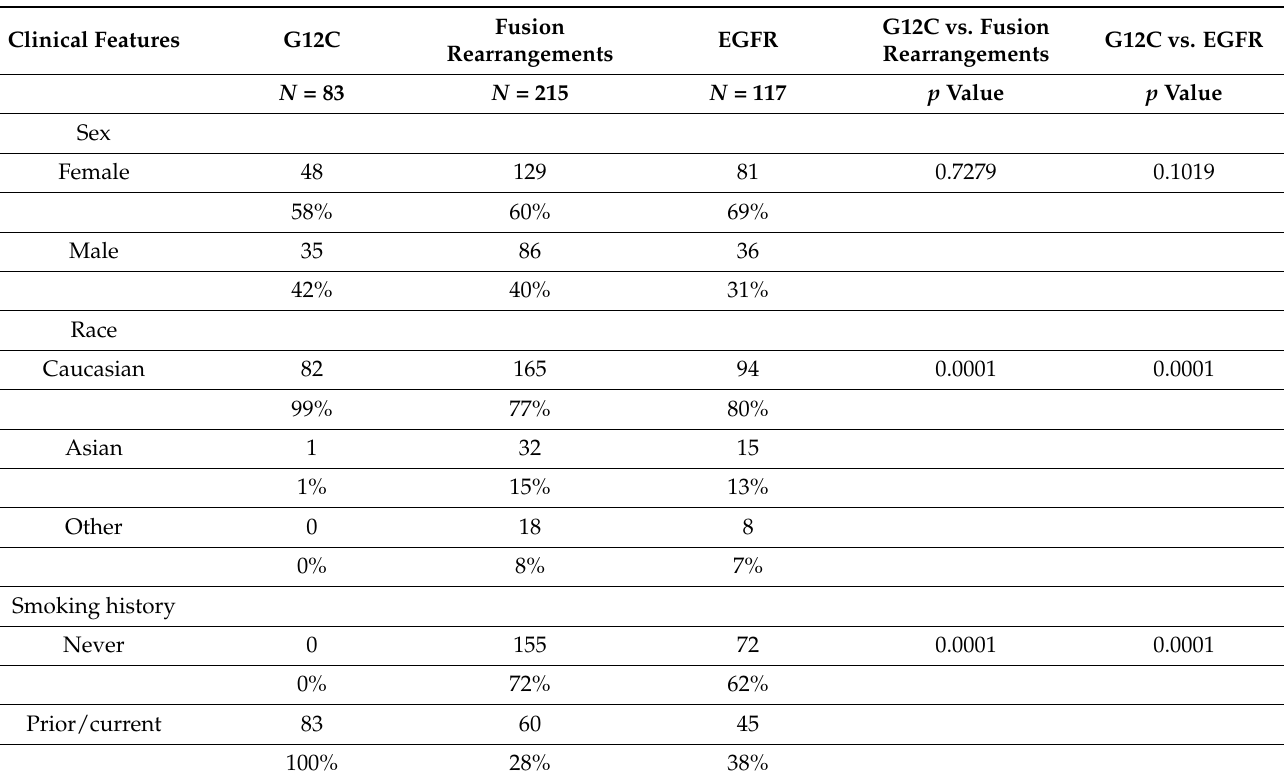
Table 4. Clinical features of G12C KRAS and non-KRAS